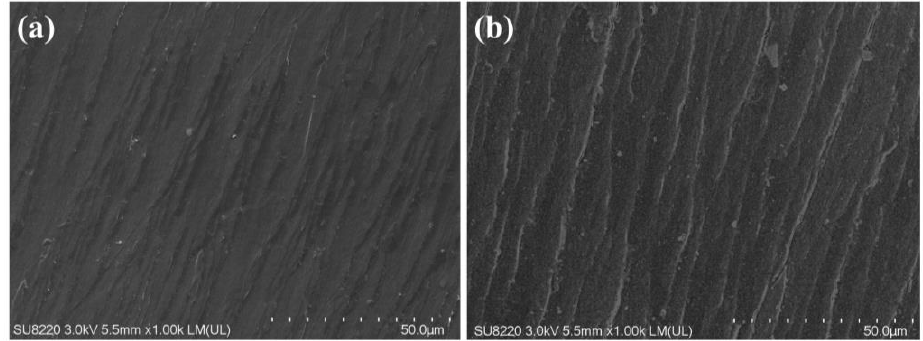
Figure 4. SEM images of the fractured surface of VE composites: ( a ) VE-0, ( b ) VE-15.